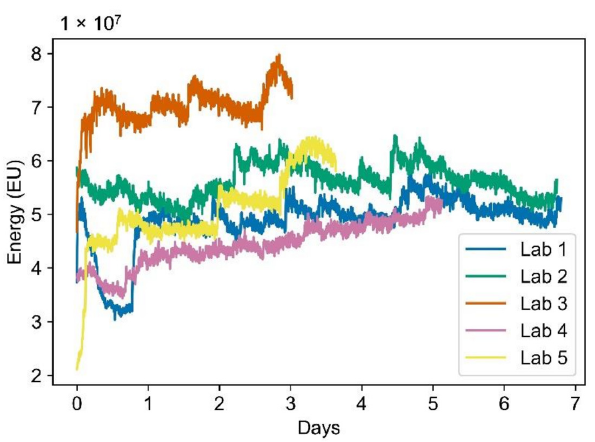
Figure 4. The first reflection energy for the first five laboratory scale fermentation